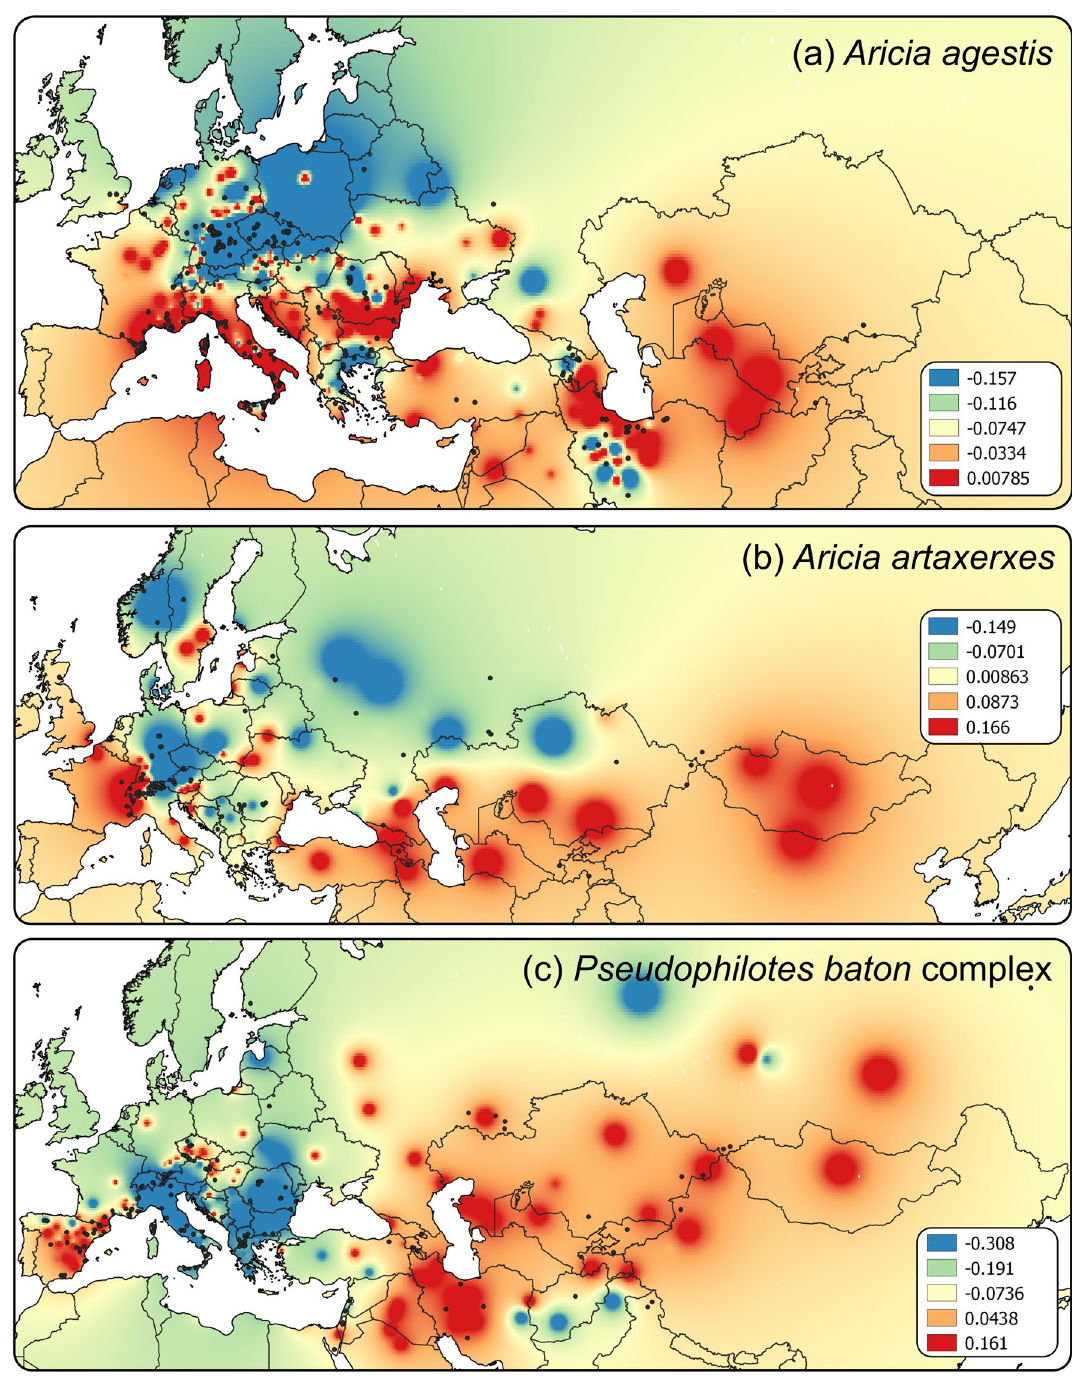
Figure 2. Genetic landscapes based on COI genetic distances among individual populations of ( a ) Aricia agestis , ( b ) Aricia artaxerxes and ( c ) Pseudophilotes baton species complex, created by the GDisPAL function in SPADS. The distance weighting parameter a = 3 was used as a presentable visualization. The map colours represent residuals of genetic distances. Maps were created in QGIS v. 2.18 (http://qgis.org) and the graphics was compiled in Inkscape v. 1.0 (https ://inksc between south-eastern and Central Europe. The dataset’s nucleotide diversity was 0.0019, which is 2.3 times lower than in A. agestis . Neither Tajima’s D (− 1.706; p > 0.05) nor Fu and Li’s D* (− 1.796; p > 0.1) tests were significant. In the mitochondrial Beast tree, haplotypes of A. agestis and A. artaxerxes formed well-defined monophyletic groups. The closest relative of Aricia artaxerxes was the Iberian A. montensis , with A. agestis being sister to this clade (Supplementary Fig. S1). Within A. agestis , Sicilian haplotypes (cluster BAPSa6) formed a well-supported lineage. A part of the haplotypes from cluster BAPSa2 (A28-A33) formed another separate lineage. Within A.